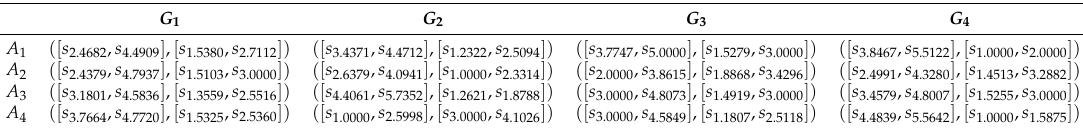
Table 5. Aggregated linguistic interval-valued intuitionistic fuzzy decision matrix R by using the LIVIFPOWG operator. G 1 G 2 G